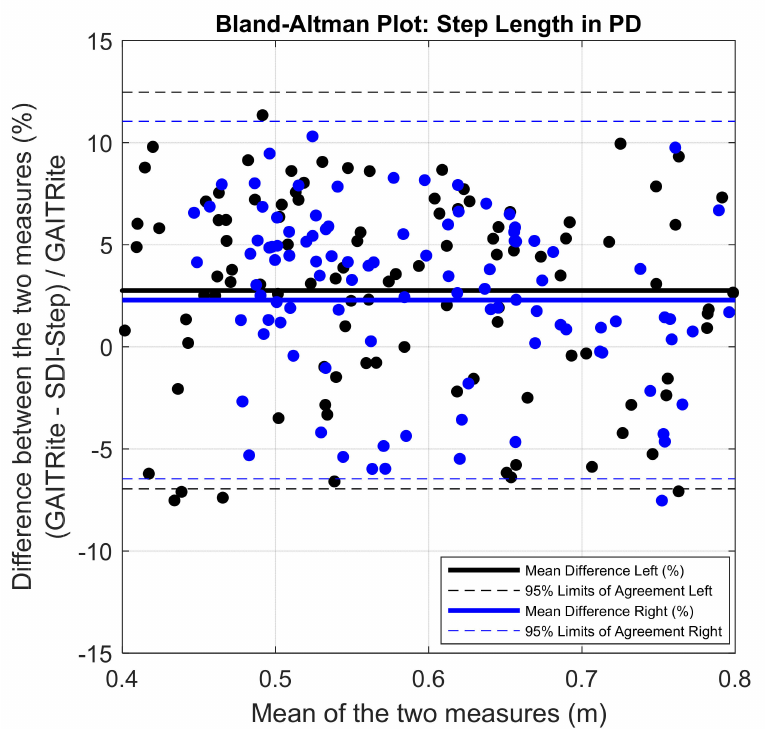
Figure 4. Bland–Altman plots demonstrating agreement between GAITRite and the SDI-Step Algorithm for right (blue) and left (black) step length in PD. Solid line represents the mean di ff erence in step length between the two measures in